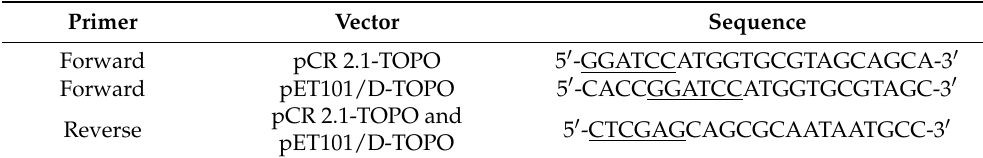
Figure 2. Restriction map of the codon-optimized human TNF- α coding sequence. Table 2. Sequences of human TNF- α gene-specific